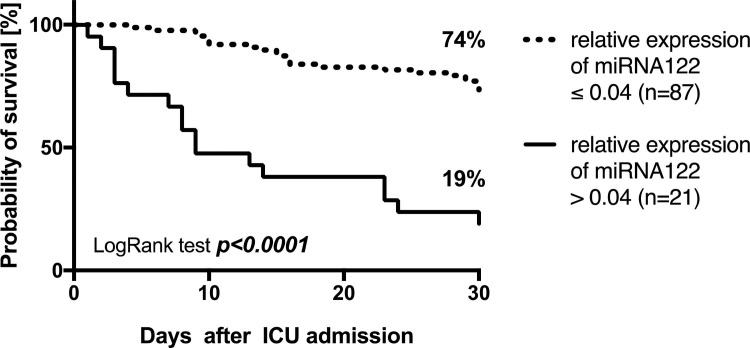
Kaplan-Meier estimates according thirty-day survival in patients with sepsis stratified for miR-122 expression.